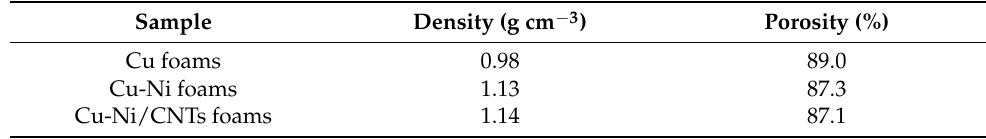
Figure 1. The TEM image of raw CNTs. Table 1. The sample name and related parameters.